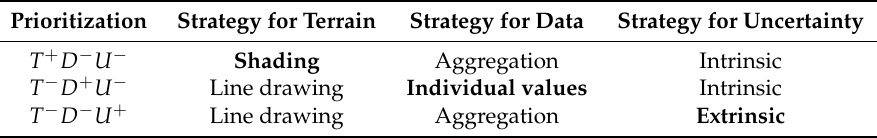
Table 1. Prioritized combination of terrain, data, and